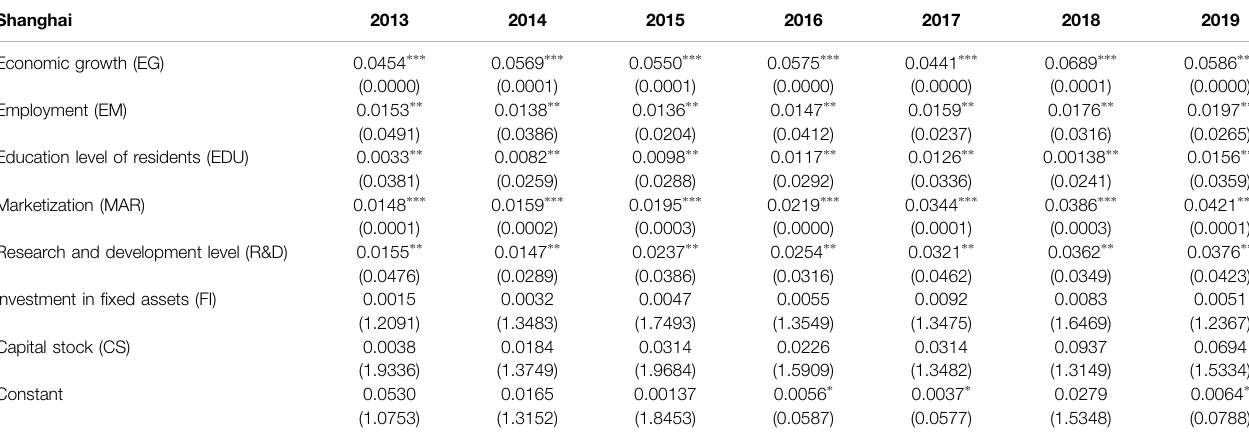
TABLE 11 | Driving force of Shanghai health tourism industry convergence. Shanghai